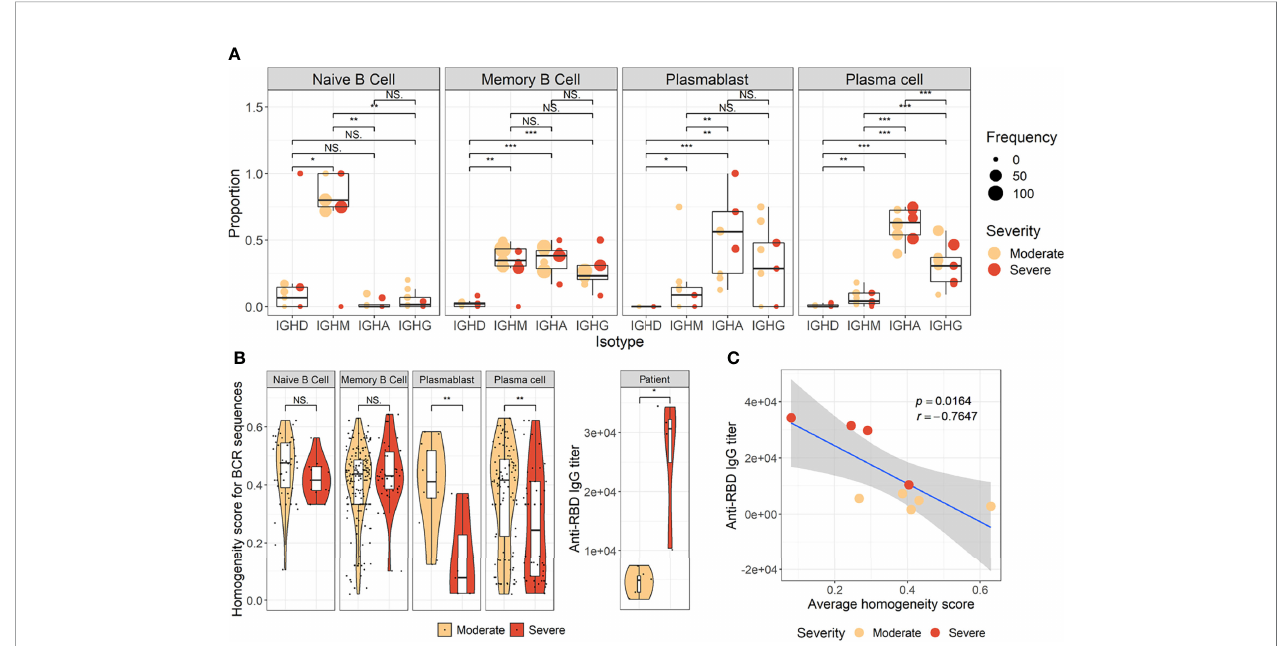
FIGURE 2 | Characteristics of B-cell response transcripts in coronavirus disease 2019 (COVID-19) patients according to cellular subtypes and disease severity. (A) Boxplots of the indicated IgH isotype proportion. Each dot represents the proportion of each indicated isotype from each patient and the circle size displays the number of cells identi fi ed. (B) Violin plots presenting BCR homogeneous scores (left panels) and anti – severe acute respiratory syndrome coronavirus 2 (anti – SARS- CoV-2) spike RBD-speci fi c IgG titers (right panel). Statistical signi fi cance was calculated by Wilcoxon rank sum test: *** p < 0.0001; ** p < 0.001; * p < 0.01. NS, not signi fi cant. (C) Correlation of anti-RBD-speci fi c IgG titers with average homogeneity score of COVID-19 patients. Statistical signi fi cance was calculated by Pearson ’ s